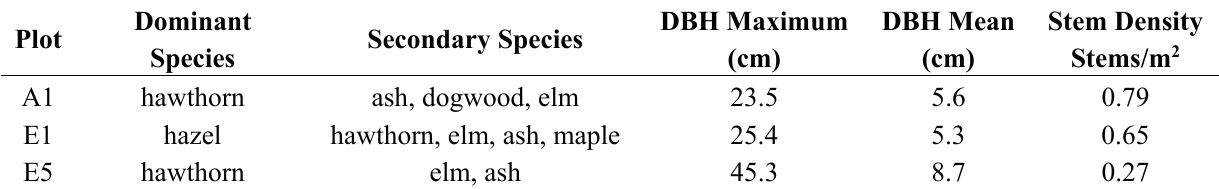
Figure 2. Kirton Wood survey plan showing location of test site within woodland and subplot position (image source: Esri, DigitalGlobe, GeoEye, i-cubed, Earthstar Geographics, CNES/Airbus DS, USDA, USGS, AEX, Getmapping, Aerogird, IGN, IGP, swisstopo, and the GIS User Community). Table 1. Description of subplots used at test site. DBH: diameter at breast height.